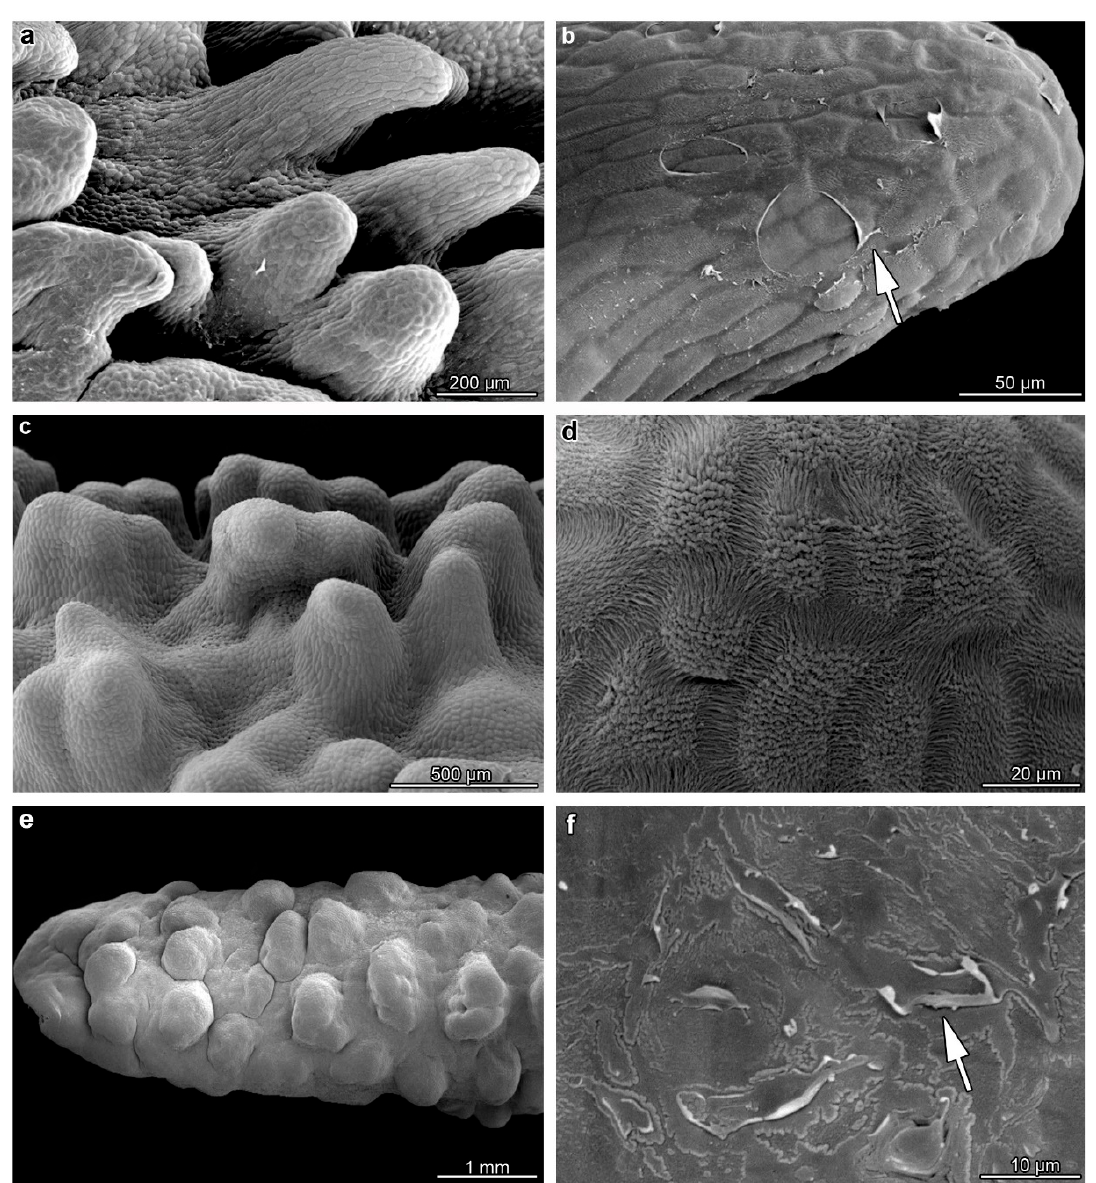
Figure 2. Micromorphological features of the adaxial surface of the labellum of B. carunculatum . ( a , b ) Elongated, multicellular outgrowths covered with ruptured cuticle ( b , white arrow) in the basal part of the lip. ( c , d ) Middle part of the lip with shorter, wide outgrowths with a strongly striated cuticle ( d ). ( e , f ) Apical part of the lip with secretory residues (white arrow) noted on the wart-like out- growths.